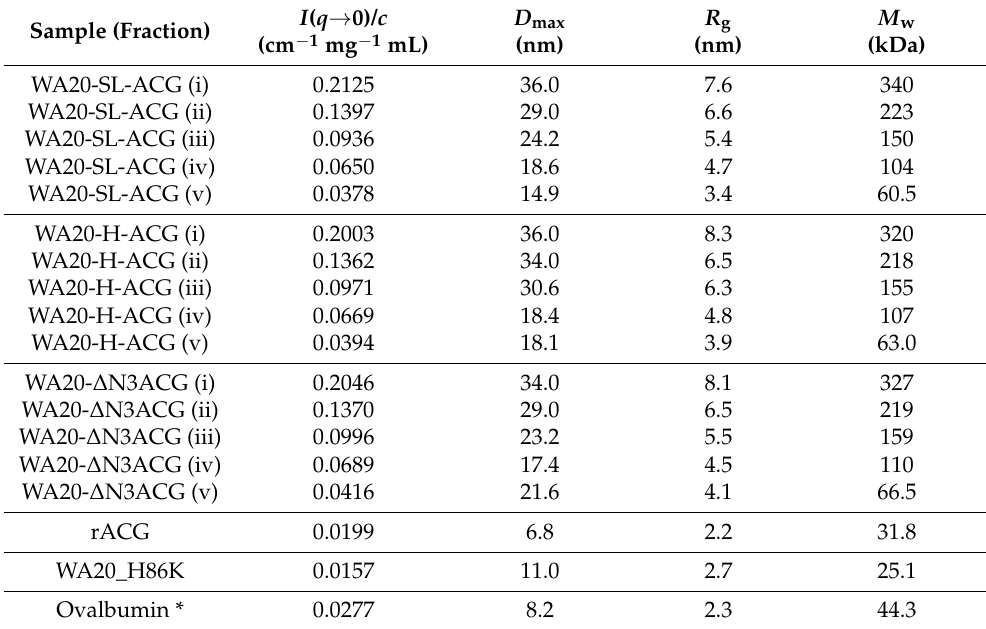
Table 2. Summary of the SAXS